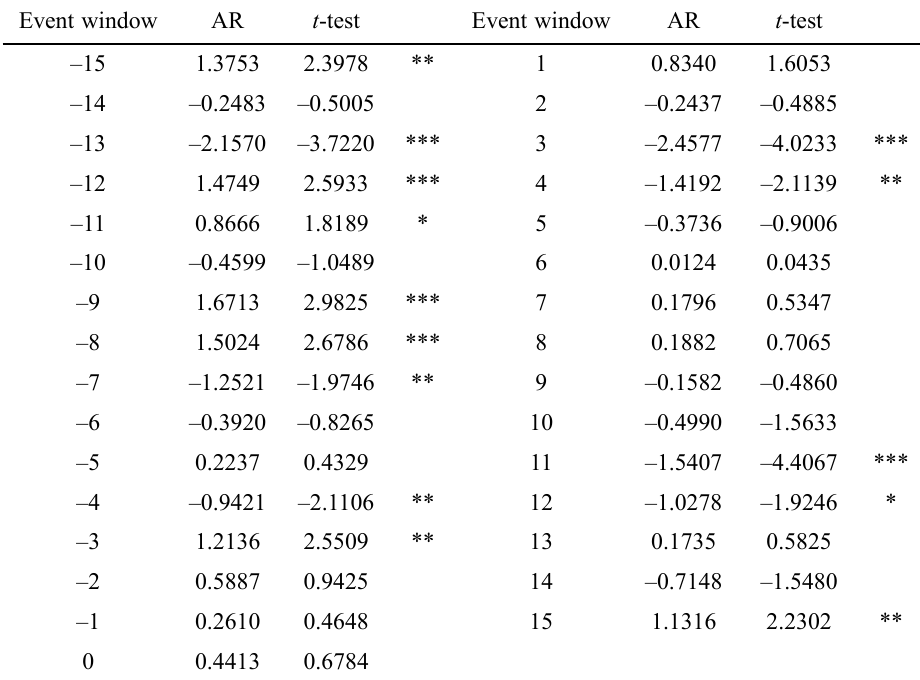
Table 5. Average AR of medical product during the period of infectious diseases Event window AR t -test Event window AR t